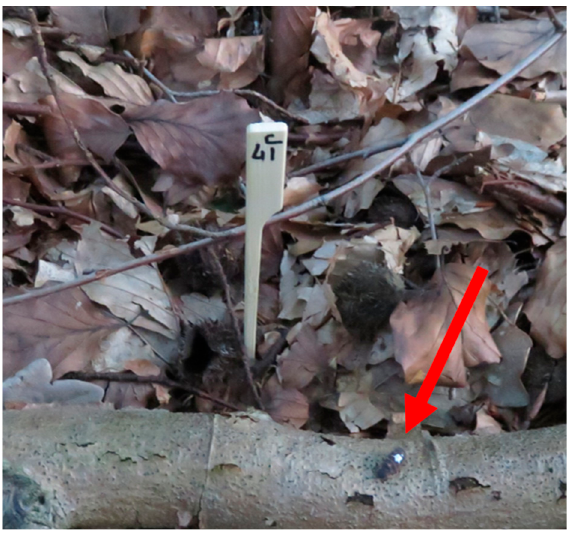
Figure A1. Marked female in the field next to a wooden stick with individual marking.